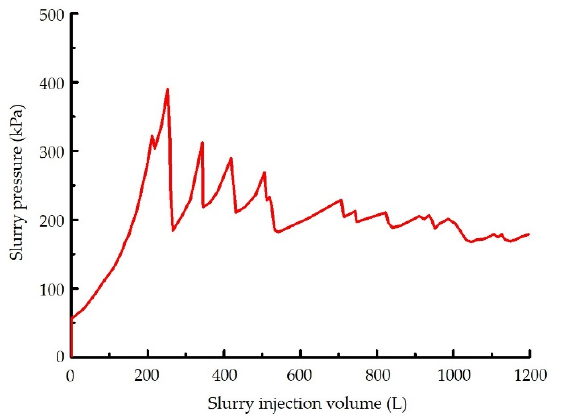
Figure 17. Variation of slurry pressure with slurry injection volume (EK4 + 820).